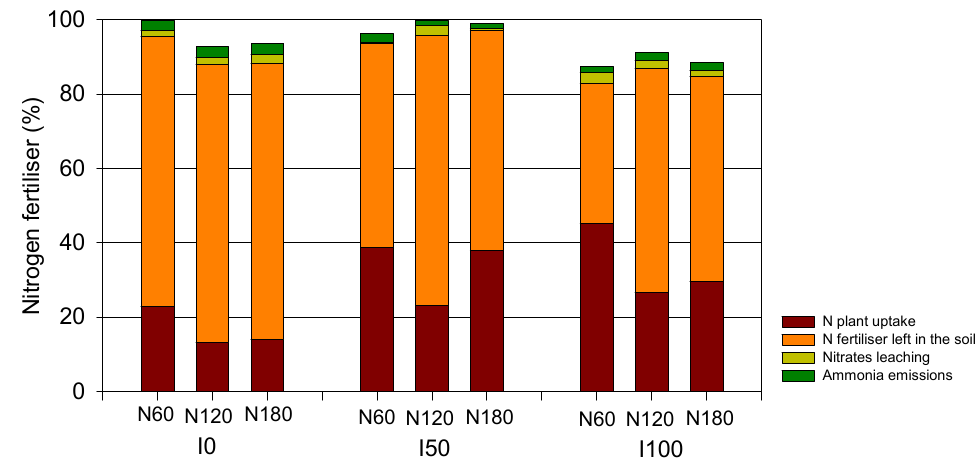
Figure 5. N fertilizer fate (%), in N fertilised treatments (N60, N120, N180 = 60, 120, 180 kg ha − 1 N, respectively), under no irrigation (I0), deficit (I50), and full (I100) irrigation, in sweet sorghum cv. Keller. The amount of N derived from the fertilizer compared to the total N, in soil water ( Ndff soil water) and therefore susceptible to leaching, was negligible under no irrigation (I0) at all N levels (<1%) (Figure 6).